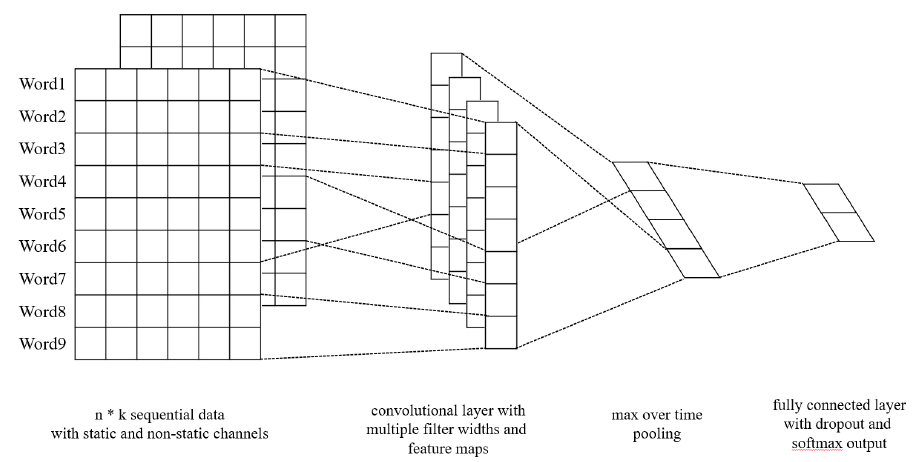
Figure 4. The structure of